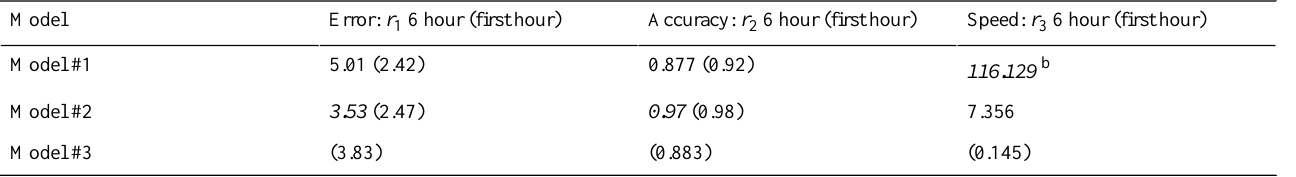
Table 1. Model scores for principal comparison.